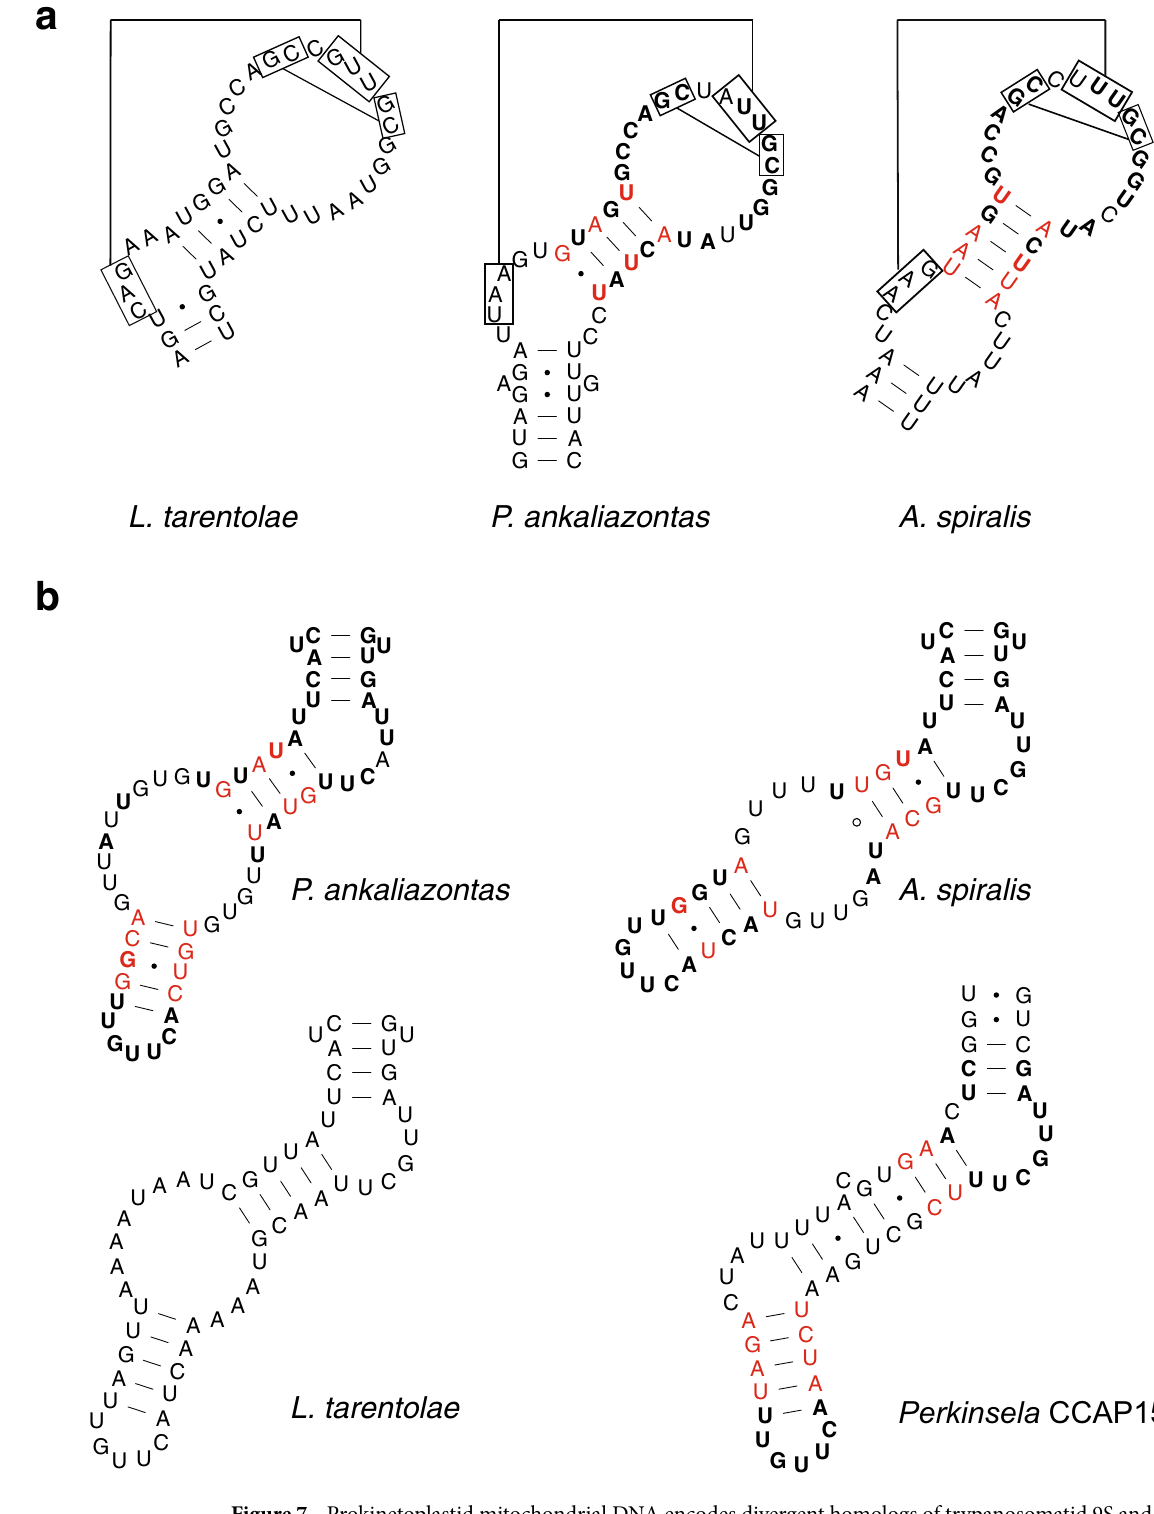
Figure 7. Prokinetoplastid mitochondrial DNA encodes divergent homologs of trypanosomatid 9S and 12S rRNAs. (a) Pattern searches for the broadly conserved ‘530 ′ loop of the small subunit rRNA gene recovered expressed homologs of the 9S rRNA gene from P. ankaliazontas and A. spiralis . (b) Expressed transcripts containing the conserved ‘A-loop’ stem-loop motif of the large subunit rRNA gene (12S) were also found in P. ankaliazontas, A. spiralis and possibly Perkinsela . Bolded and red nucleotides denote identity and compensatory base changes between prokinetoplastid and L. tarentolae homologs, respectively. Boxes in ( a ) highlight complementary nucleotides known to participate in longer range interactions with each